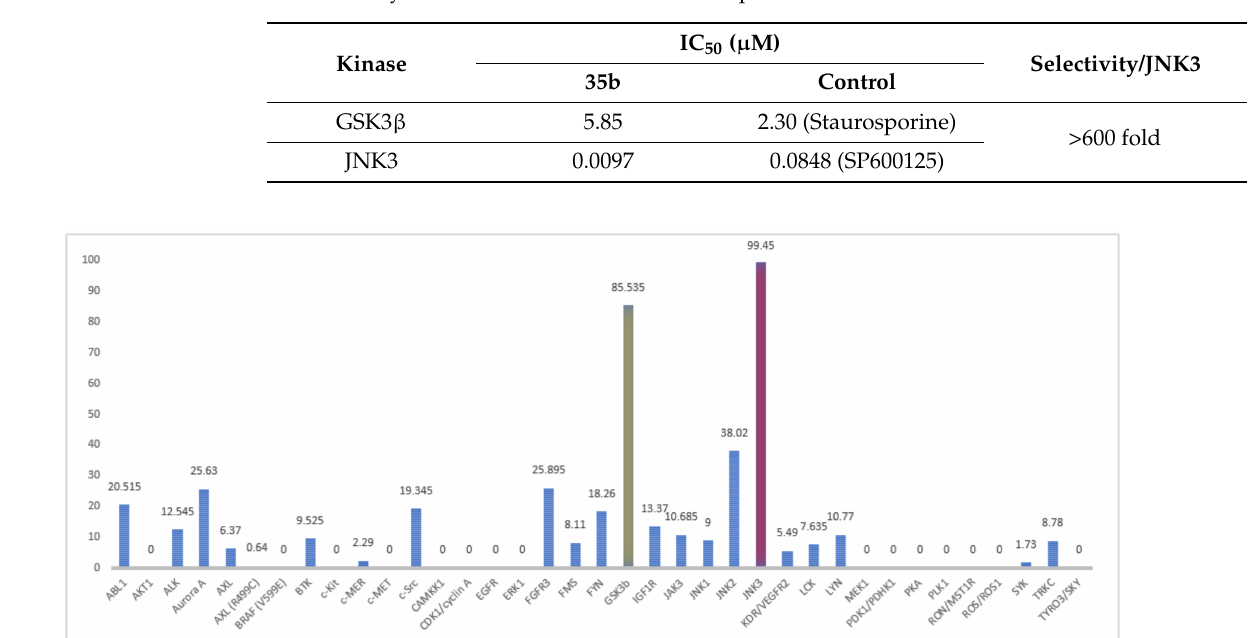
Table 3. Enzymatic activities of 35b on selected protein kinases.